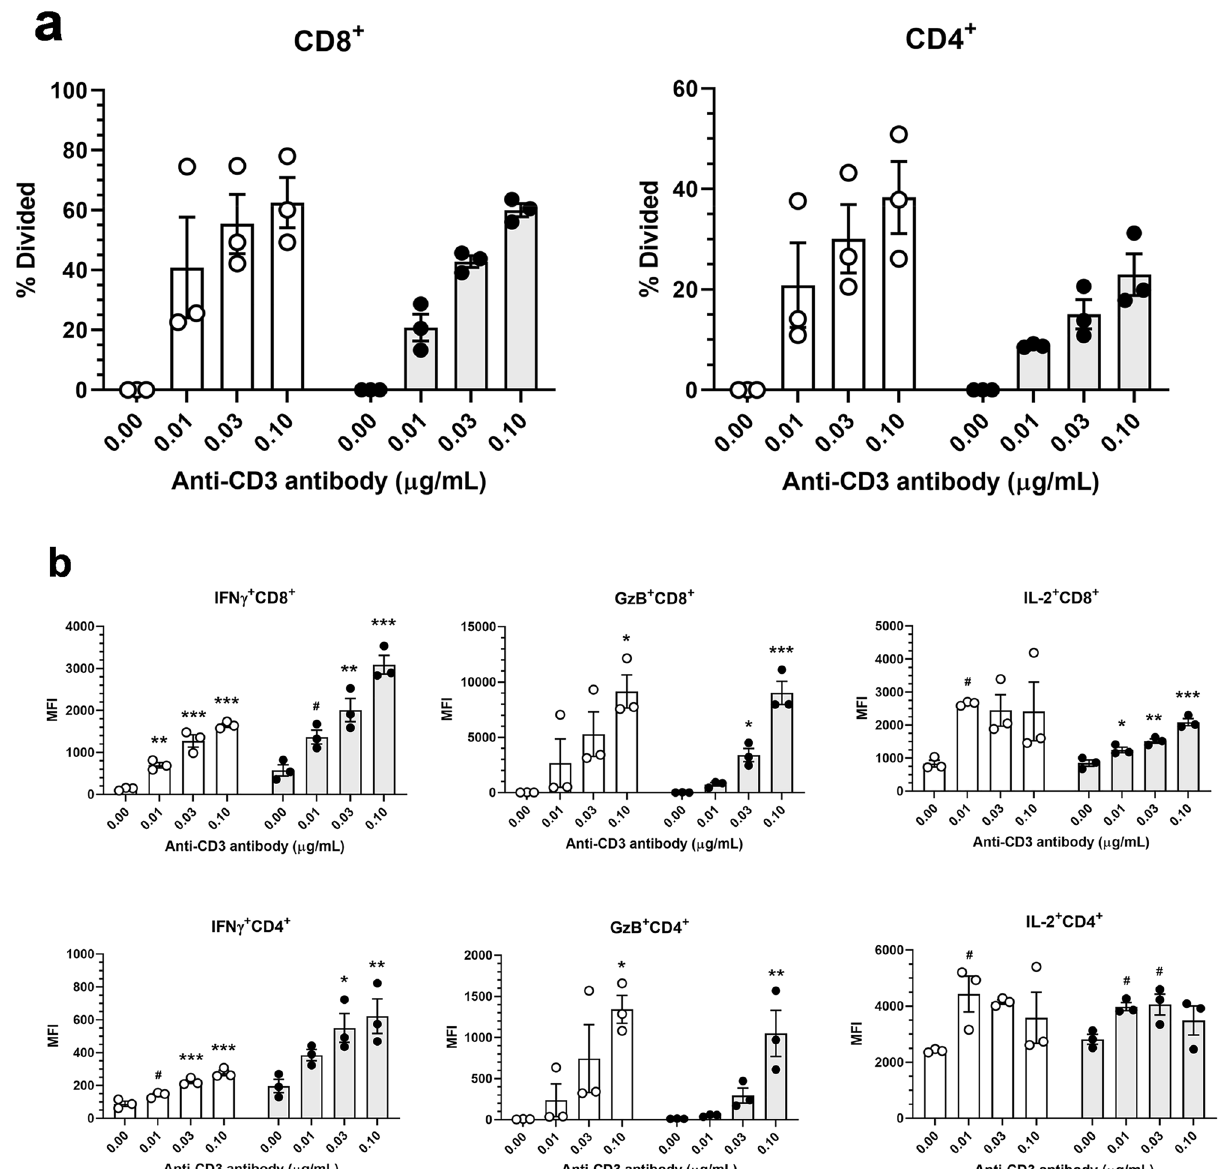
Figure 4. Cytokine and granzyme B (GzB) production in T cells derived from C57BL/6 J (B6) and B6 ESC CAG-Azami-green → CD1- Foxn1 nu / nu chimeric mice. Splenic T cells were labeled with CellTrace Violet and activated with anti-CD3 antibody (0, 0.01, 0.03, or 0.1 μg/mL) for 3 days, and then underwent flow cytometry. ( a ) Percentages of divided cells, as determined by using CellTrace Violet staining and FlowJo software. Open circles, B6 mice; filled circles, chimeric mice. Mean ± S.E.M. n = 3 per group. ( b ) Mean fluorescence intensity (MFI) of interferon-γ (IFNγ), GzB, and interleukin 2 (IL-2) positivity of CD4 + and CD8 + T cells. Values were analyzed by Dunnett’s multiple comparisons test among the B6 groups (open circles) or chimera groups (filled circles). *, **, and *** indicate P < 0.05, P < 0.01, and P < 0.001, respectively, and # indicates P < 0.10, vs. the vehicle group. Mean ± S.E.M. n = 3 per